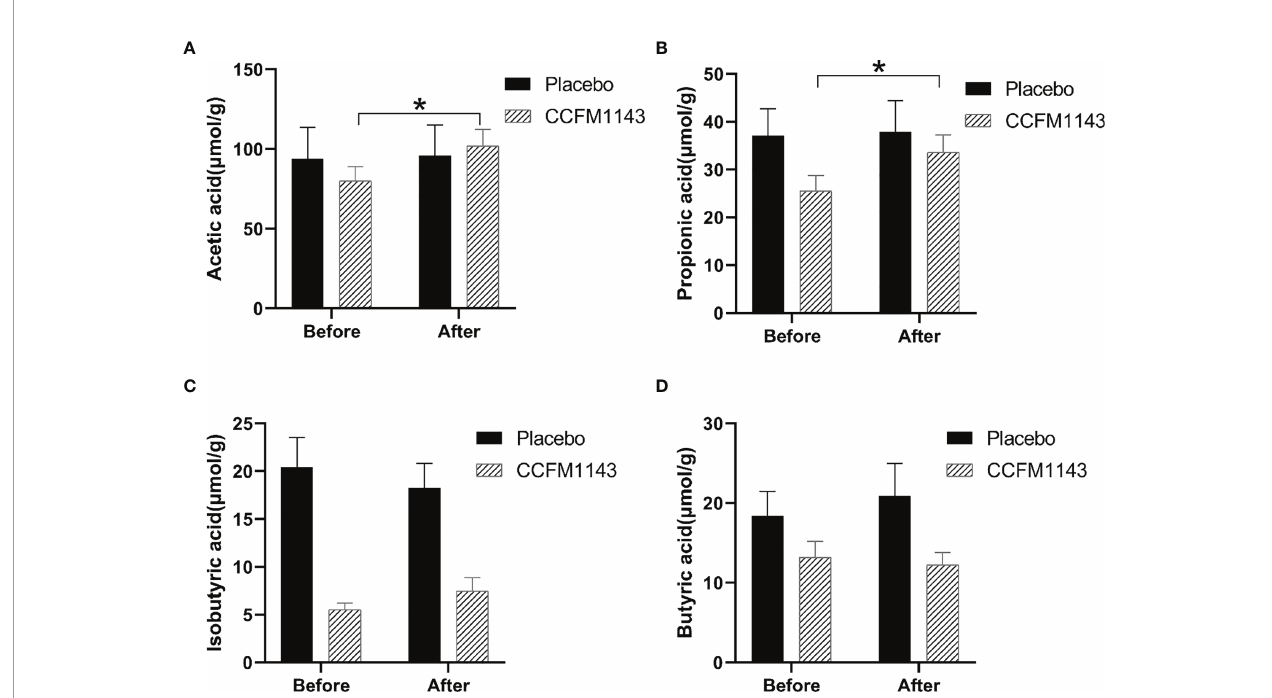
FIGURE 3 | Effect of Lactobacillus plantarum CCFM1143 on short-chain fatty acids (SCFAs) in patients with diarrhea. (A – D) Concentrations of acetic acid (A) , propionic acid (B) , isobutyric acid (C) , and butyric acid (D) in feces. * p <